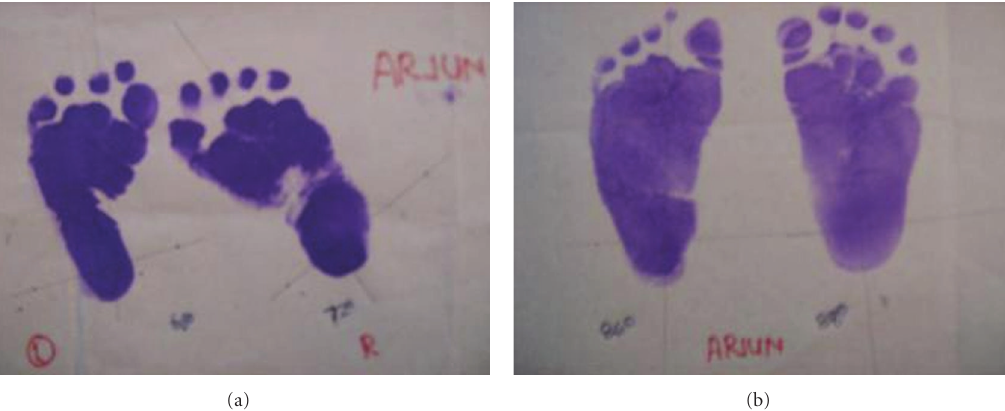
Figure 5: (a) Precorrection podograms showing reduced foot bimalleolar angles. (b) Postcorrection podograms showing improved foot bimalleolar angles achieved by